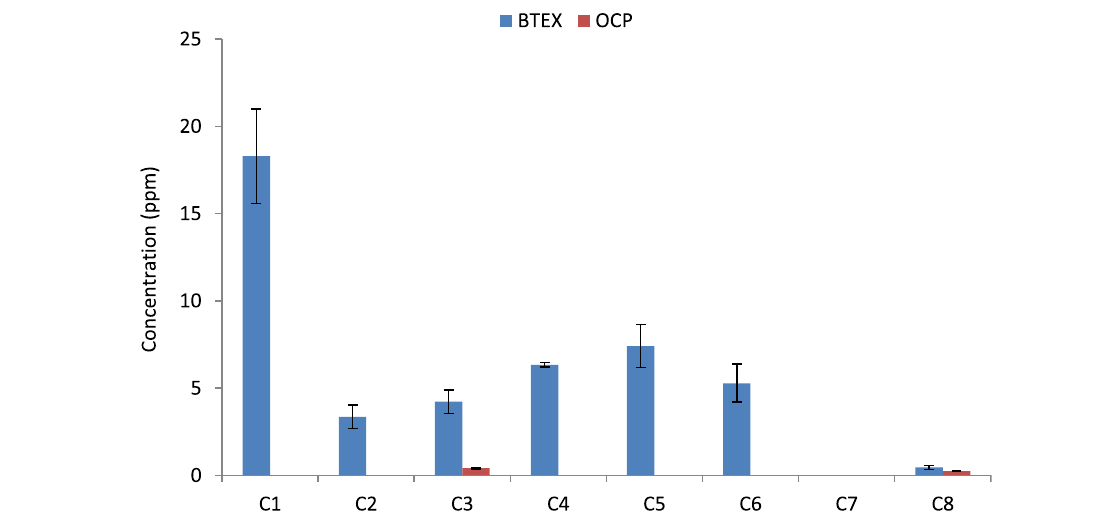
Fig. 4 Comparative concentrations of BTEX components and OCP congeners in the tissue of S. clarias . BTEX: benzene (C1), toluene (C2), chlorobenzene (C3), ethylbenzene (C4), m + p-xylene (C5), o-xylene (C6), 1,3-dichlorobenzene (C7), and 1,4-dichlorobenzene (C8). OCP: d-BHC (C1), 4,4-DDE (C2), 4,4-DDT (C3), endosulfan 1 (C4), aldrin (C5), dieldrin (C6), endrin (C7), and heptachlor